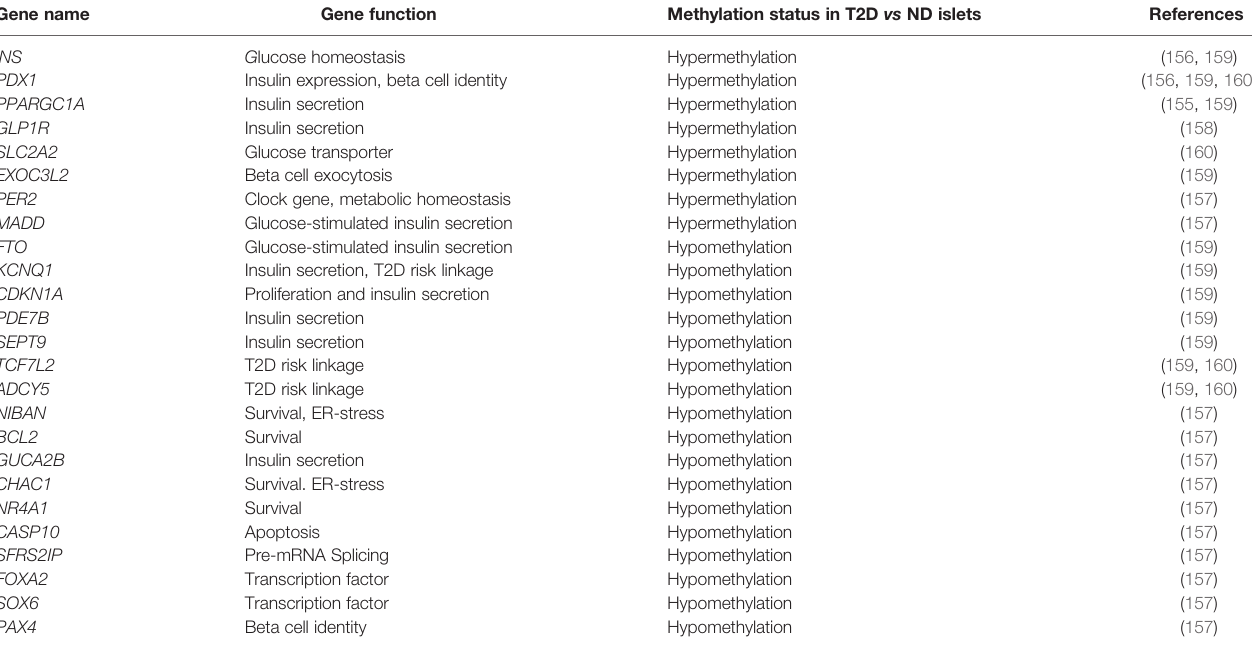
TABLE 2 | DNA methylation status of the key genes related to beta cell homeostasis in human islets in the context of